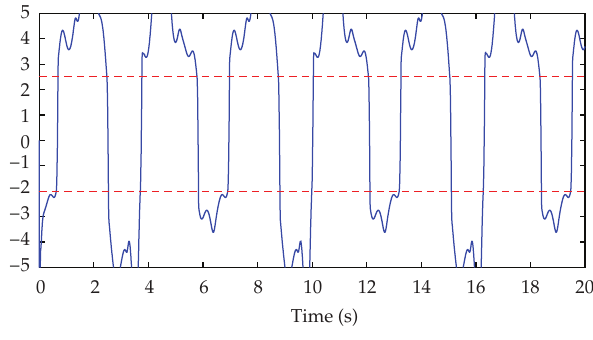
Figure 3: Zoom of Figure